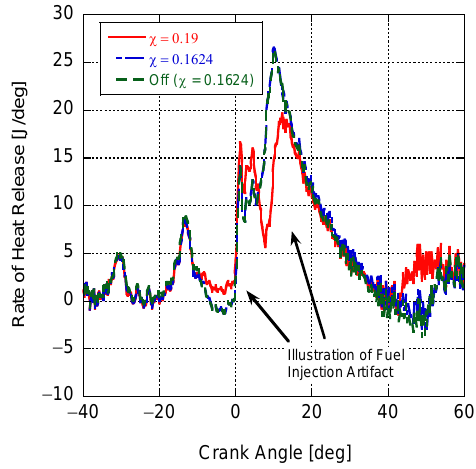
Figure 5. Rate of heat release on a per degree basis highlighting the injection artifact as a function of the evaporation parameter. The figure also illustrates what the rate of heat release looks like when the corresponding fuel injection terms are removed from the calculation. Single localized combustion reaction.